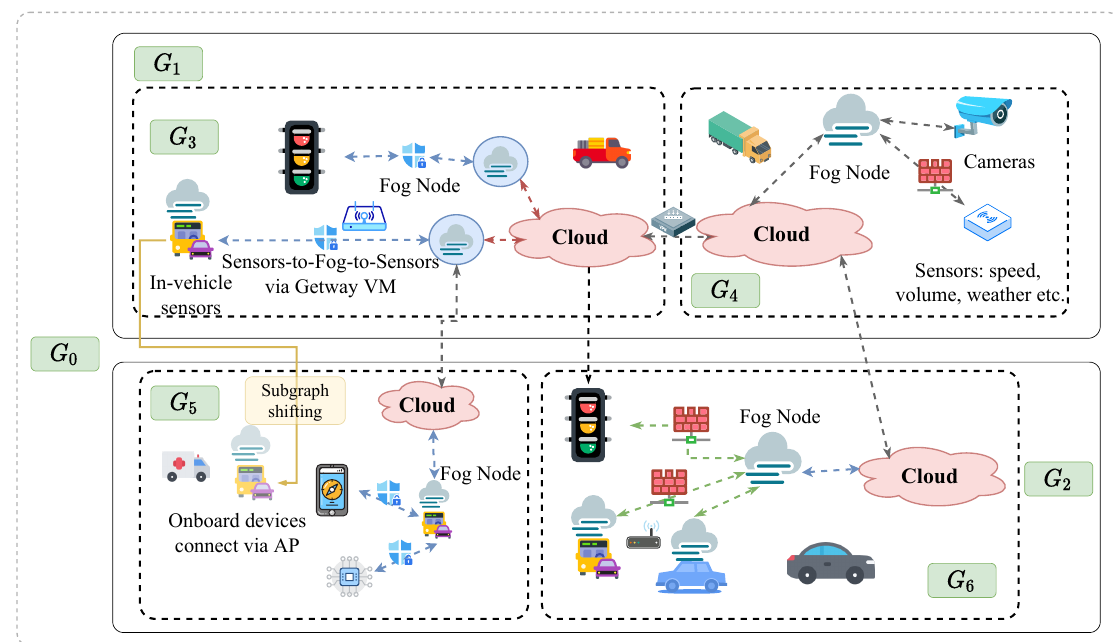
Figure 2. The intelligent transportation networks requiring VNF chain